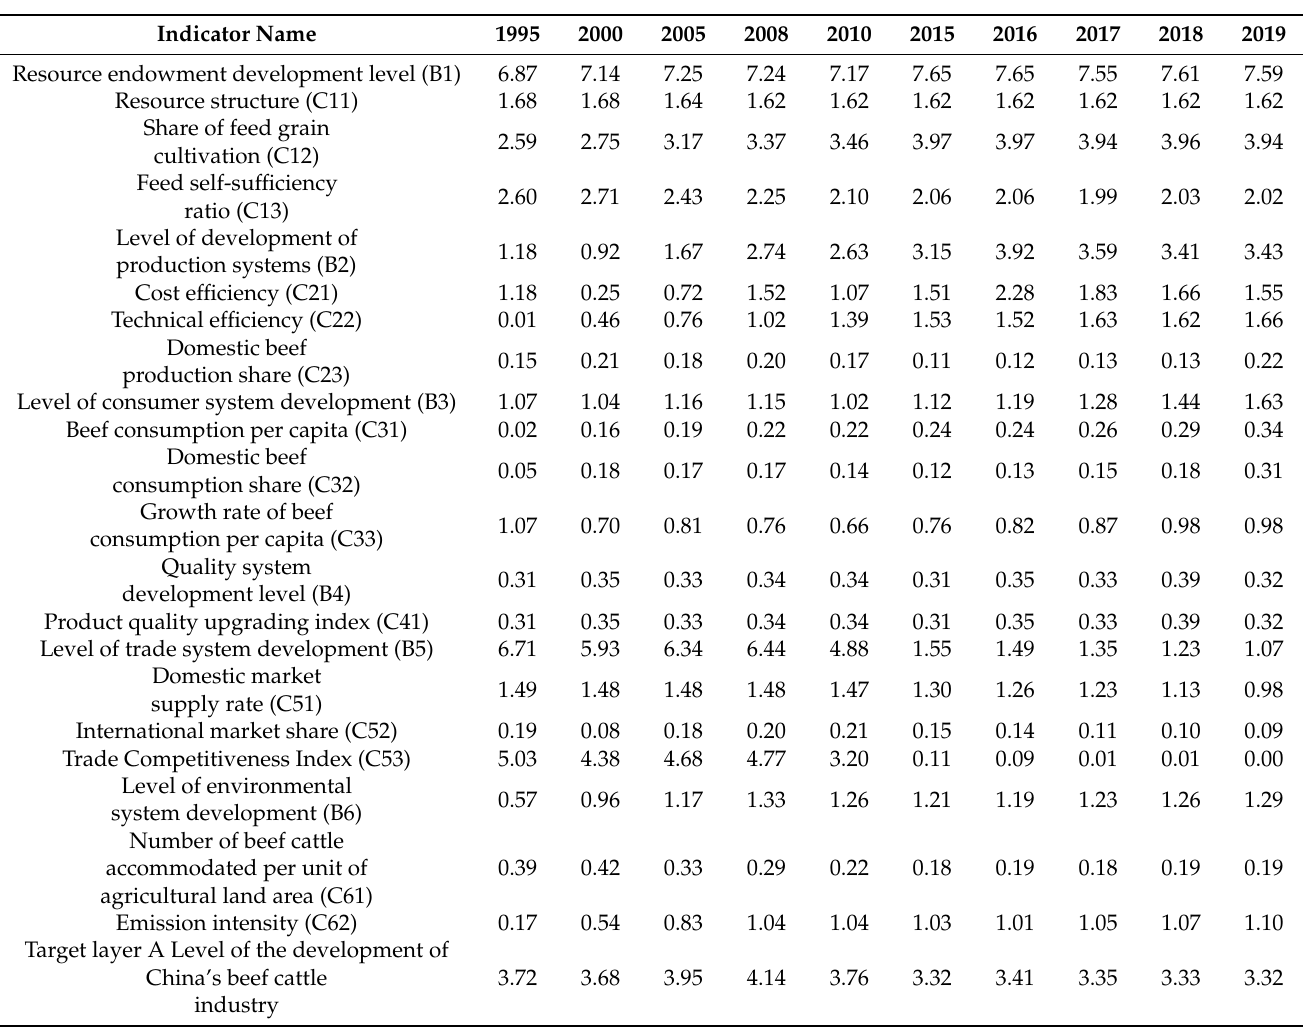
Table 2. Changes in the level of development of China’s beef cattle industry and the level of development of each subsystem,